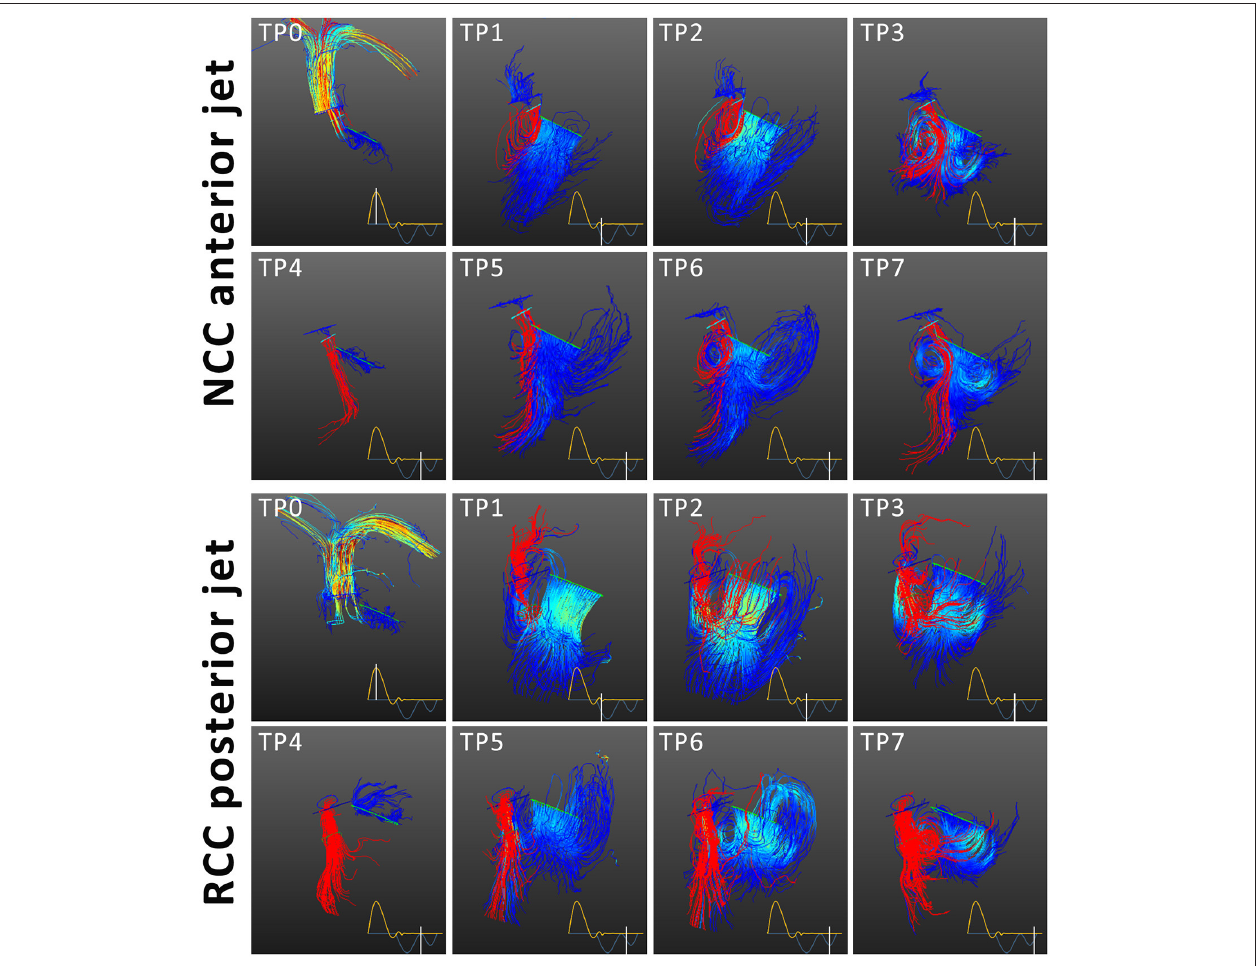
FIGURE 3 | Streamline tracing of blood flow for NCC and RCC paravalvular leakage. Mitral inflow in blue and aortic regurgitant jet in red. The time points correspond to ejection (TP0), E-wave acceleration (TP1) peak E-wave (TP2) E-wave deceleration (TP3), diastasis (TP4), A-wave acceleration (TP5), peak A-wave (TP6), A-wave